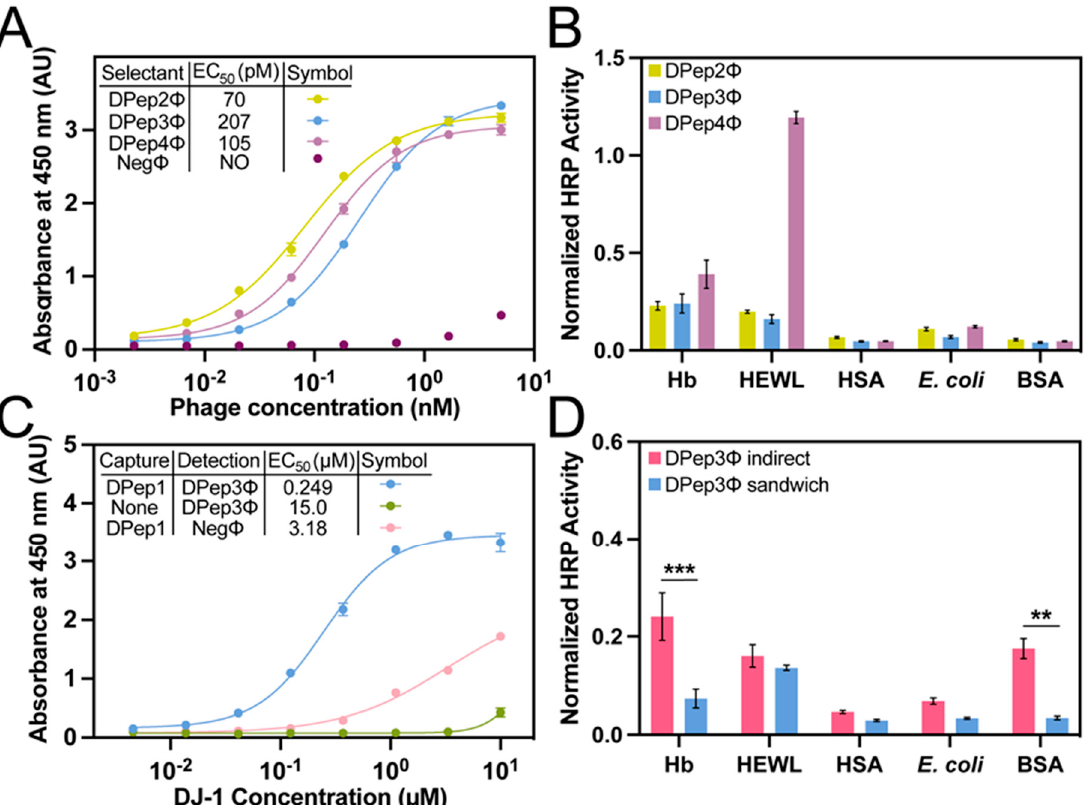
Figure 3. Sensitivity and specificity determination of sandwich peptide selectants. ( A ) A dose- dependent direct phage assay with sandwich peptide selectants binding to DJ-1. Sub-micromolar phage EC 50 values were observed. NO = not observed. ( B ) An indirect phage assay with Hb, HEWL, HSA, E. coli lysate, and BSA determined the specificity of the sandwich selectants. Data are normalized to the DJ-1 signal. ( C ) Streptavidin-bound DPep1 peptide assay for sandwiching the target DJ-1 with DPep3 Φ . The resultant dose-dependent response yielded an EC 50 for binding to DJ-1 of 249 pM. ( D ) The DPep1-DPep3 Φ sandwich interaction also demonstrated the interac- tion’s improved selectivity for DJ-1. ANOVA with Sidak’s multiple comparisons yielded p -values of <0.01 (**) and <0.001 (***). ELISA data were fit to a four-parameter logistic curve. Error bars, included for every data point, depict standard error of the mean (SEM) ( n =